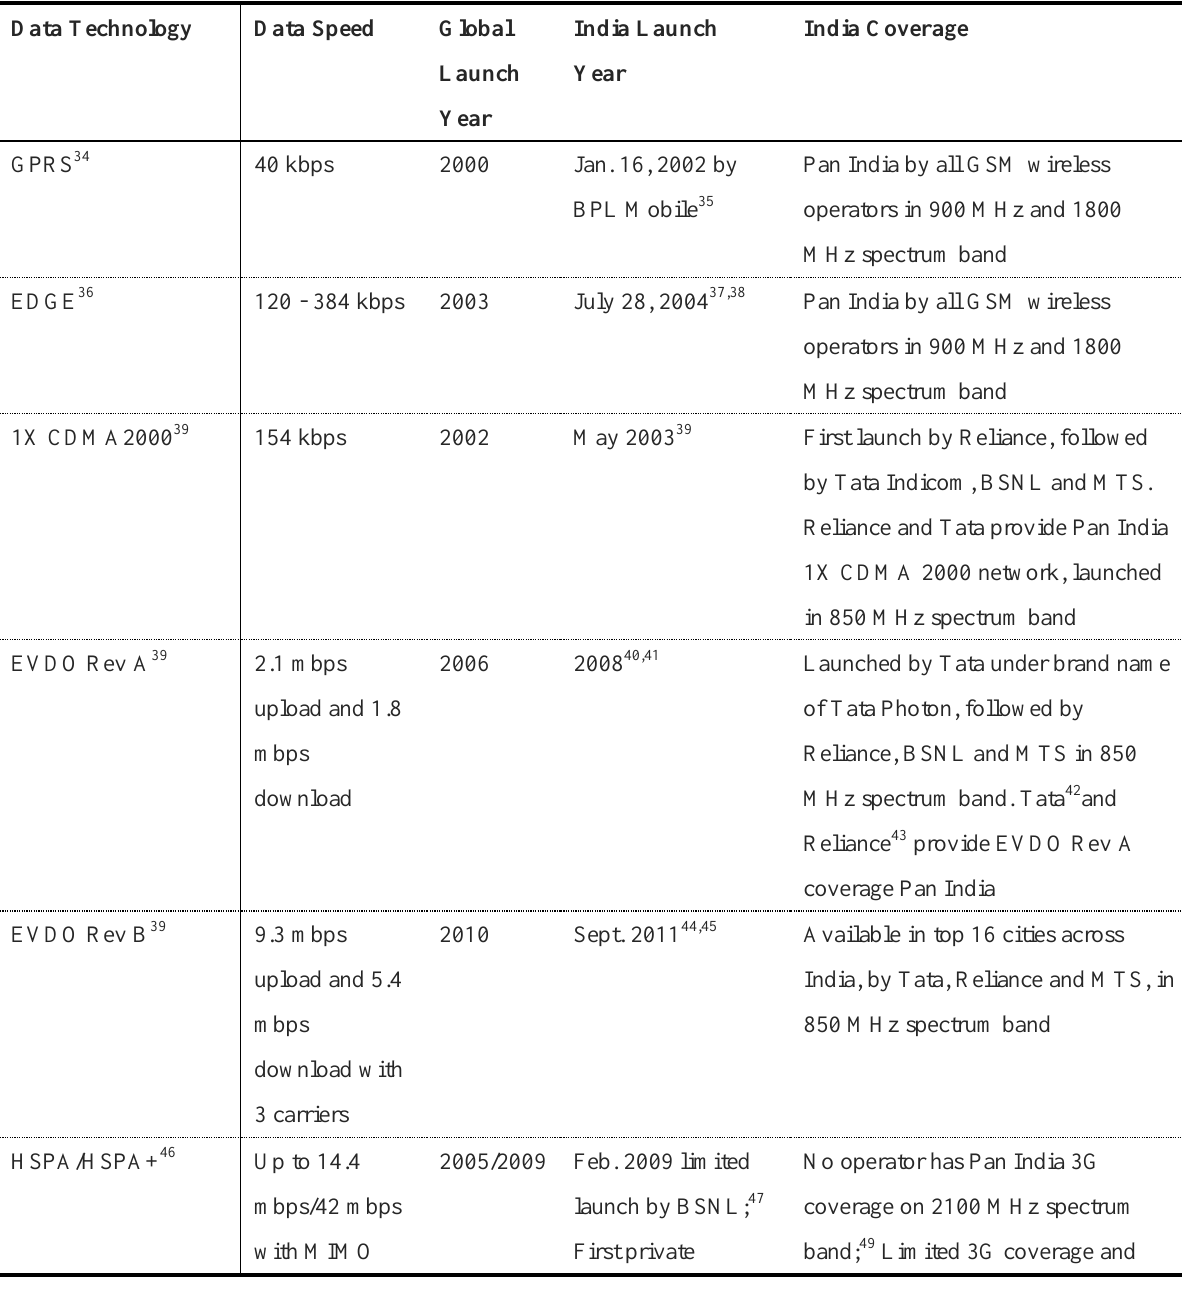
Table 2: Technological details of current telecommunication services and its launch in